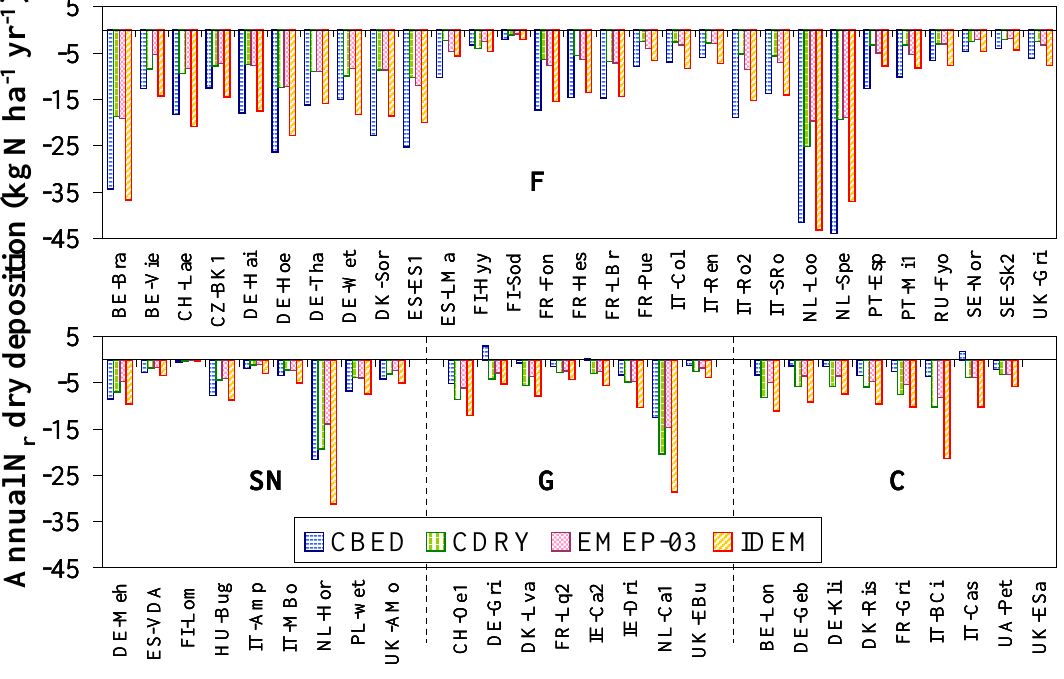
Fig. 4. Modelled annual N r dry deposition to NEU monitoring sites. Data are calculated as the sum of NH 3 , HNO 3 , aerosol NH + fluxes from DELTA measurements, plus NO 2 dry deposition from modelled (EMEP 50 × 50km) or measured NO 2 concentrations.